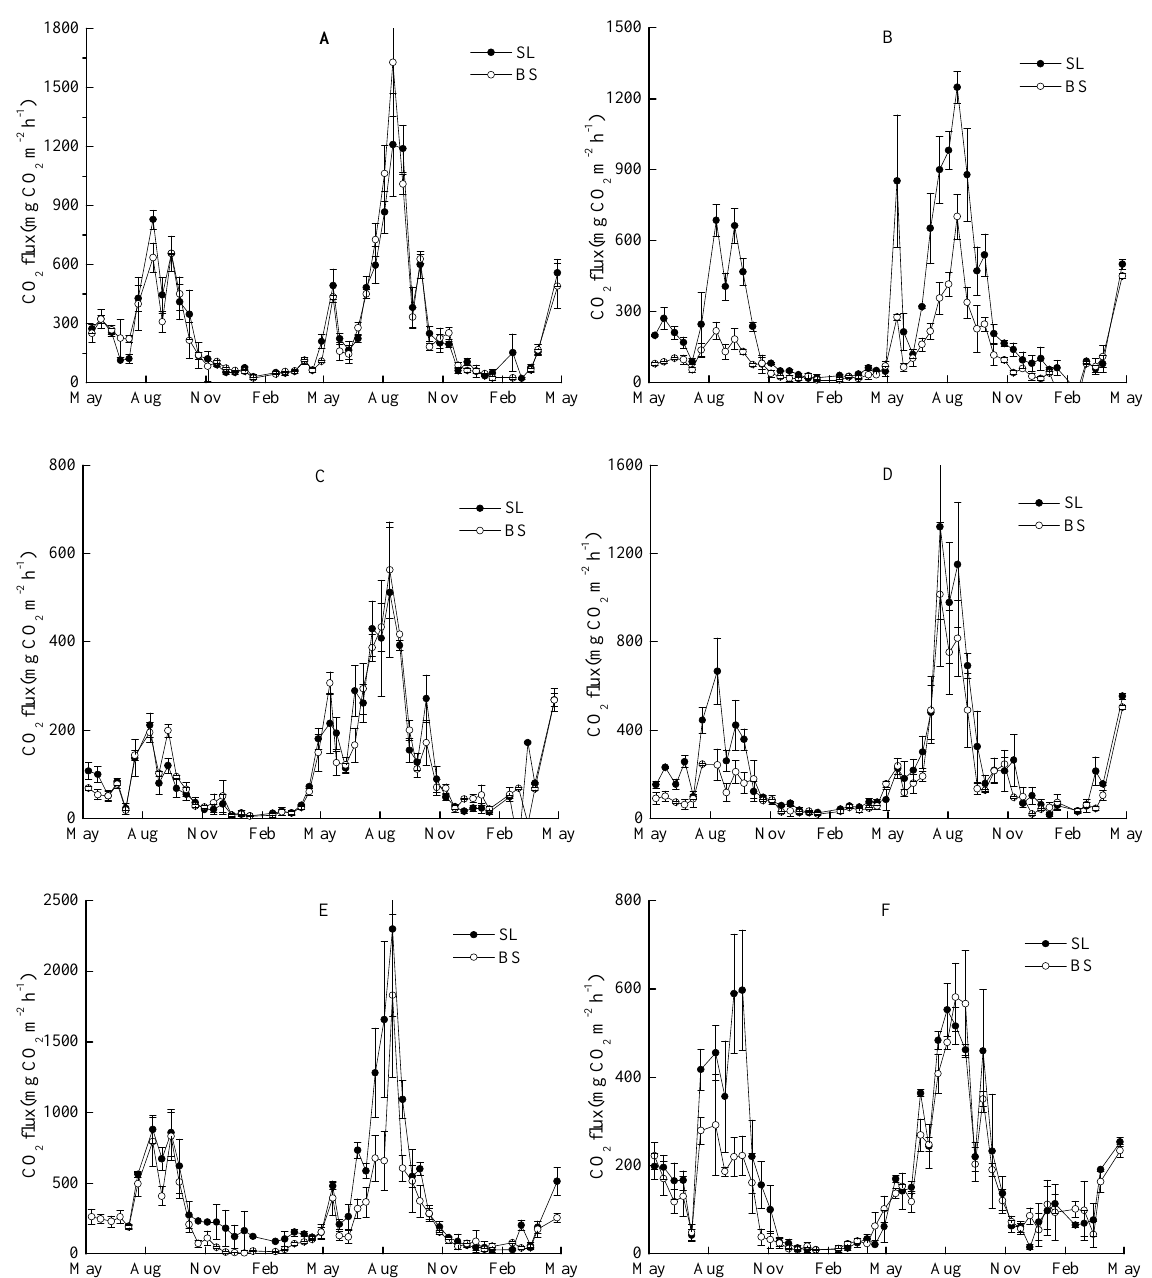
Fig. 3. Seasonal patterns of CO 2 flux rates measured in six tree species on Taihang Mountain with (SL) or without (BS) surface litter from May 2010 to April 2012. The tree species are (A) Robinia pseudoacacia , (B) Vitex negundo var. heterophylla , (C) Leptodermis oblonga , (D) Punica granatum , (E) Ziziphus jujube , and (F) Bothriochloa ischcemum . The error bars represent standard errors ( n = 3).